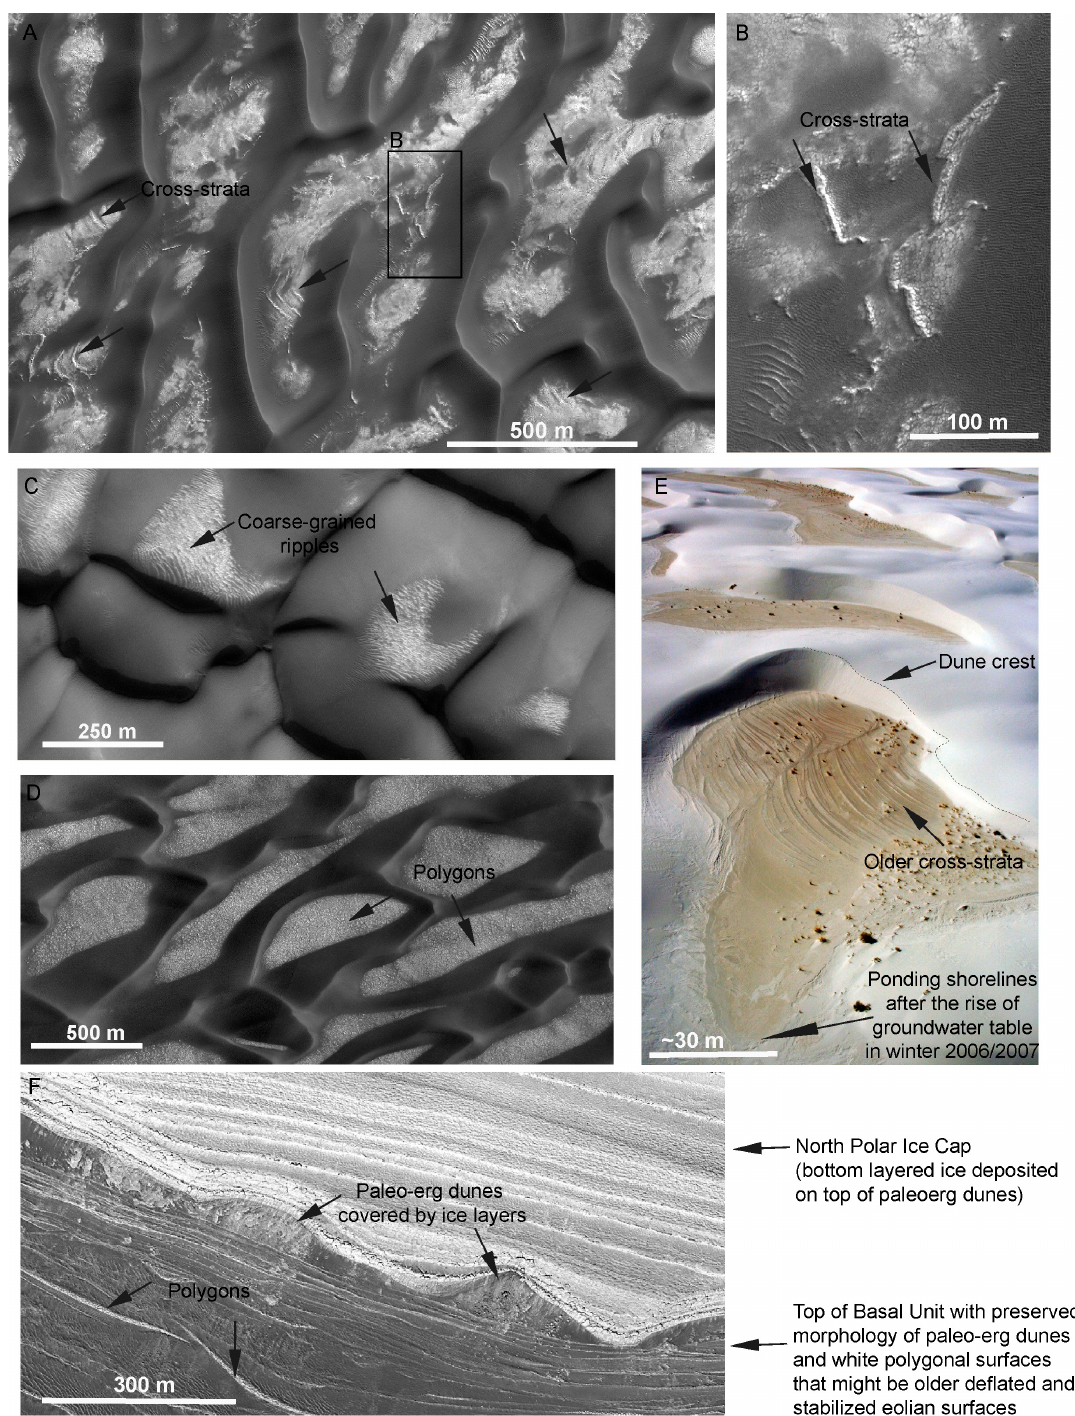
Figure 5. ( A , B ) Portions of HiRISE image PSP_009898_2615 showing sections of the Olympia Undae dunes and bright albedo interdunes with the cross-strata left by migrating dunes ( A ) and polygons ( B ). ( C ) Portion of HiRISE image PSP_010049_2795 showing examples of bright albedo ripples in the interdunes of Olympia Undae. ( D ) Portion of HiRISE image PSP_010071_2615 showing examples of bright albedo surfaces with polygons in the interdunes of Olympia Undae. ( E ) Examples of the cross-bedding strata and interdune gypsum crusts formed after groundwater rise in the interdunes of the White Sands Dune Field, New Mexico (Oct 2007). Image credit: A. Szynkiewicz. ( F ) Portion of HiRISE image PSP-010097_2650 showing the top section of the upper basal unit covered by the Ice